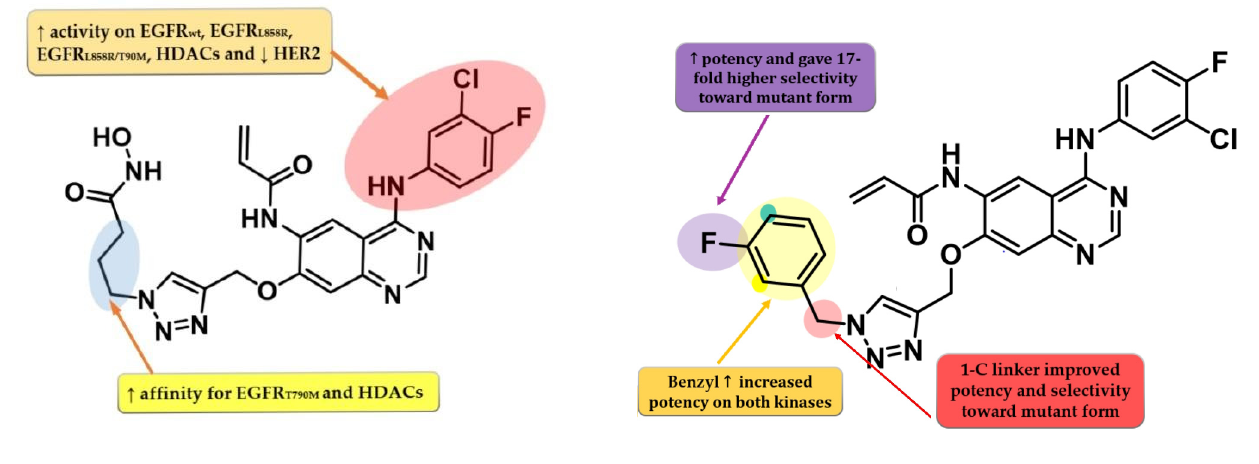
Figure 23. Structure–activity relationship of compound 34, as reported by Zhao et al. [178]; structure–activity relationship of compound 35, as reported by Song et al. [179].